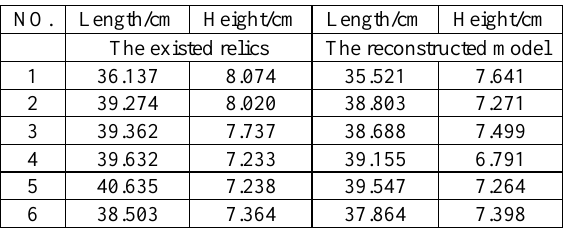
Table 1. The size of the selected